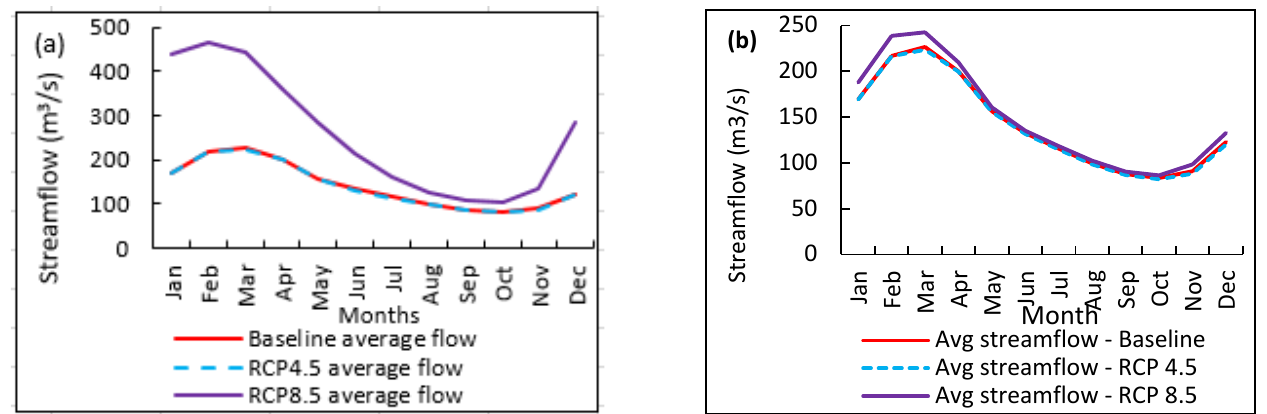
Figure 5. Monthly mean streamflow ensembles under ( a ) high uncertainty and ( b ) strong consensus. The ensemble mean streamflow for RCP 8.5 indicates a sharp rise from November to January, while for RCP 4.5, there is a moderate rise from November to January. The pre- dictions from the ensemble mean streamflow indicate an increased magnitude of stream- flow for RCP 8.5, which may culminate into flooding of most parts of the basin depending on topography, whereas RCP 4.5 generally indicate a slightly lower streamflow when compared to the baseline flow. In order to determine the actual increase or decrease of the ensemble mean streamflow in Figure 6, the change factor methodology (CFM) [39] was applied.